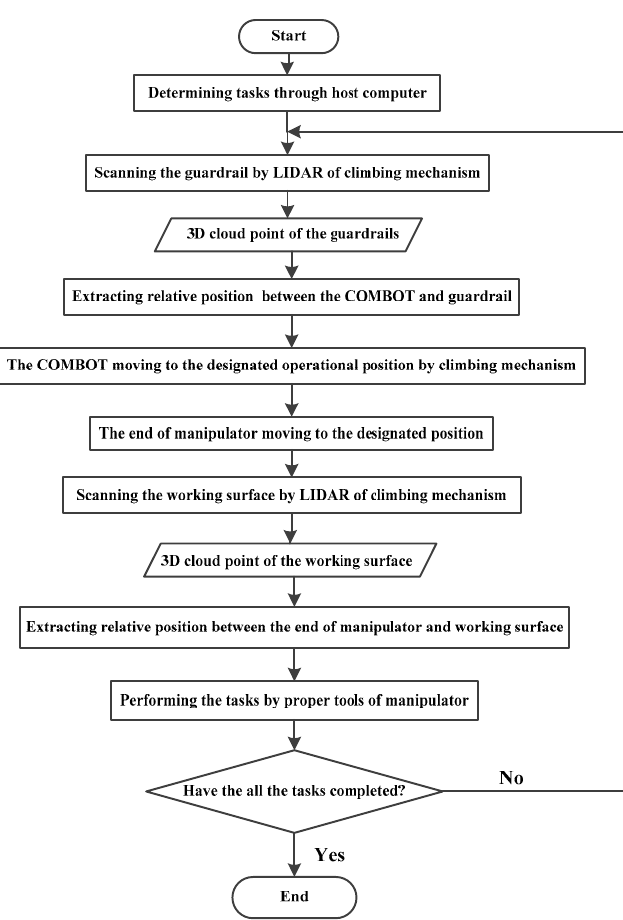
Figure 8. Flowchart of the work process of the CMBOT.